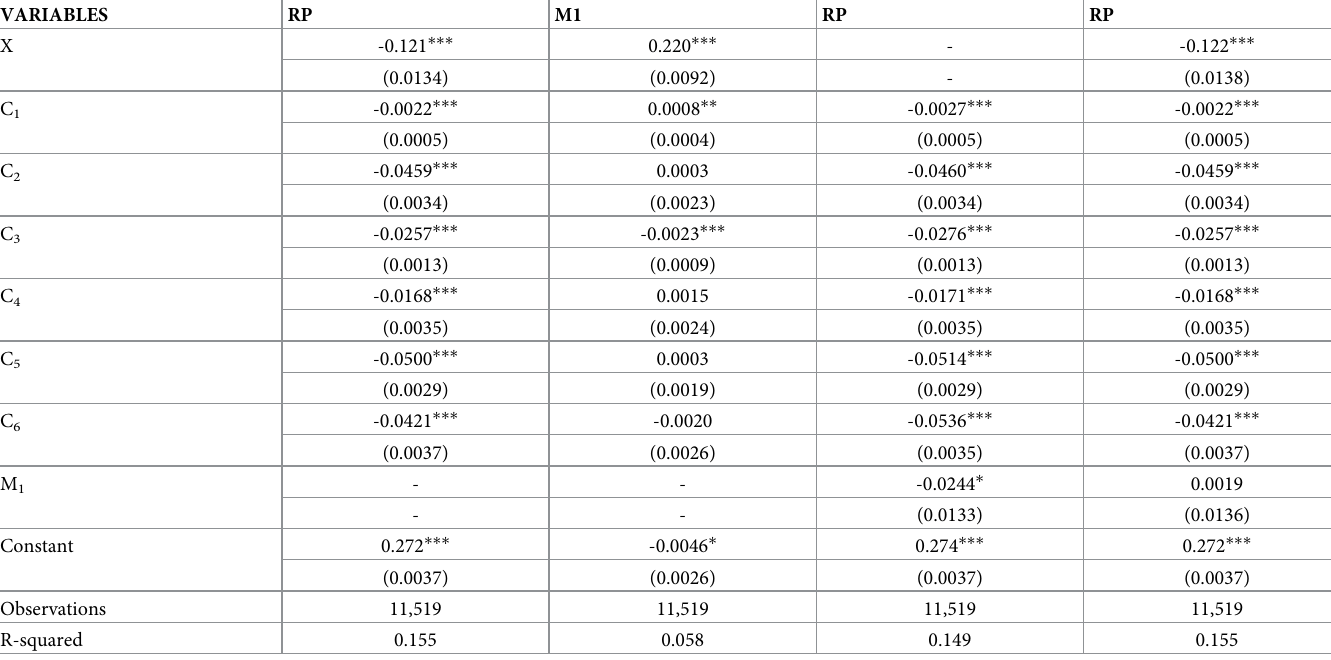
Table 5. Test of the mediating effect of productive